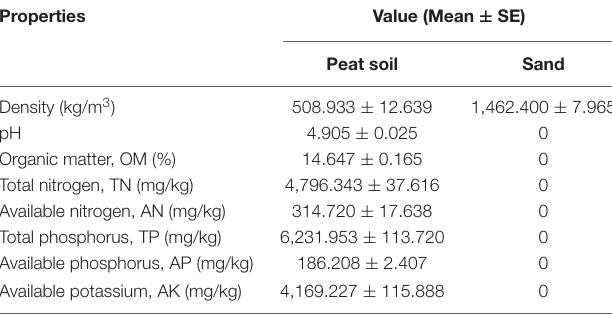
TABLE 1 | Basic characteristics of experimental soil